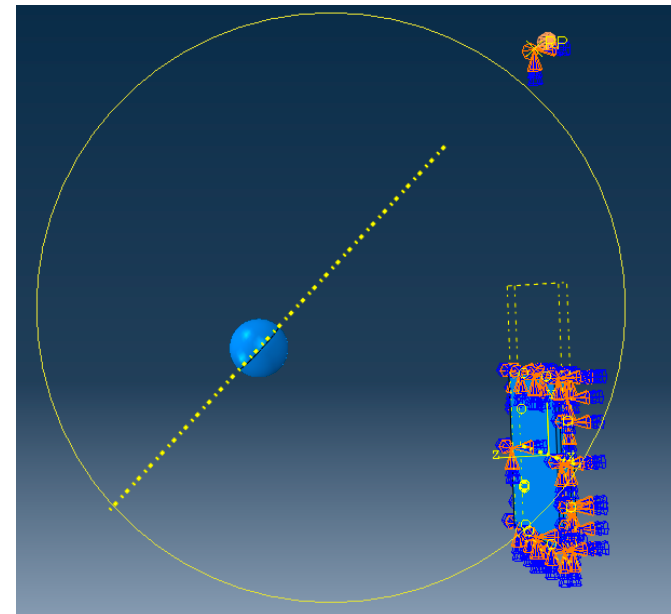
Figure 11. A pendulum impact test.